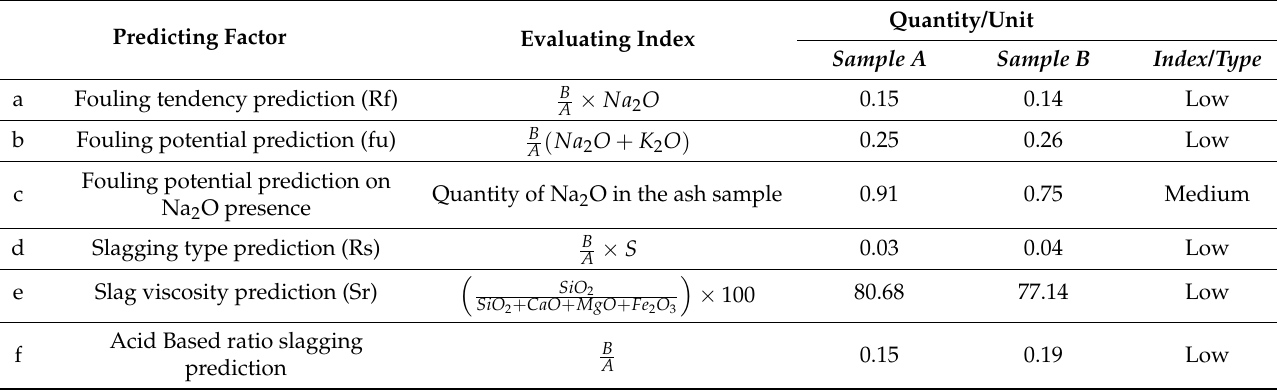
Table 6. Evaluated fouling and slagging prediction for Sasol coal-fired